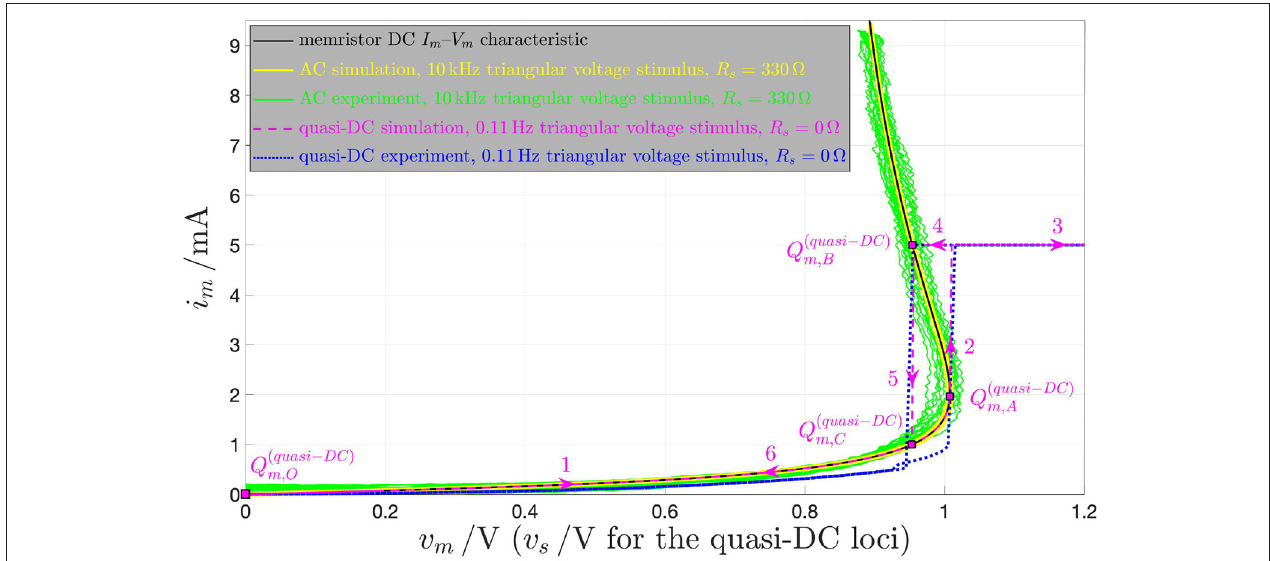
FIGURE 19 | Black solid curve: DC I m – V m locus of the NbO memristor, as derived from Figure 2C for I m [0,10] mA. Blue dotted (magenta dashed) curve: quasi-DC ∈ i m vs. v s characteristic of the NbO device, as extracted through measurements (by means of a numerical simulation of the model), where a purely positive periodic v s triangular voltage signal v s of amplitude 1.45V and frequency f 0.11Hz was applied directly across the memristor—see Figure 17 for more details—until each ˆ = = time instant at which, during an abrupt off-to-on threshold switching process, the current i m through the micro-structure attained a compliance level I c set to